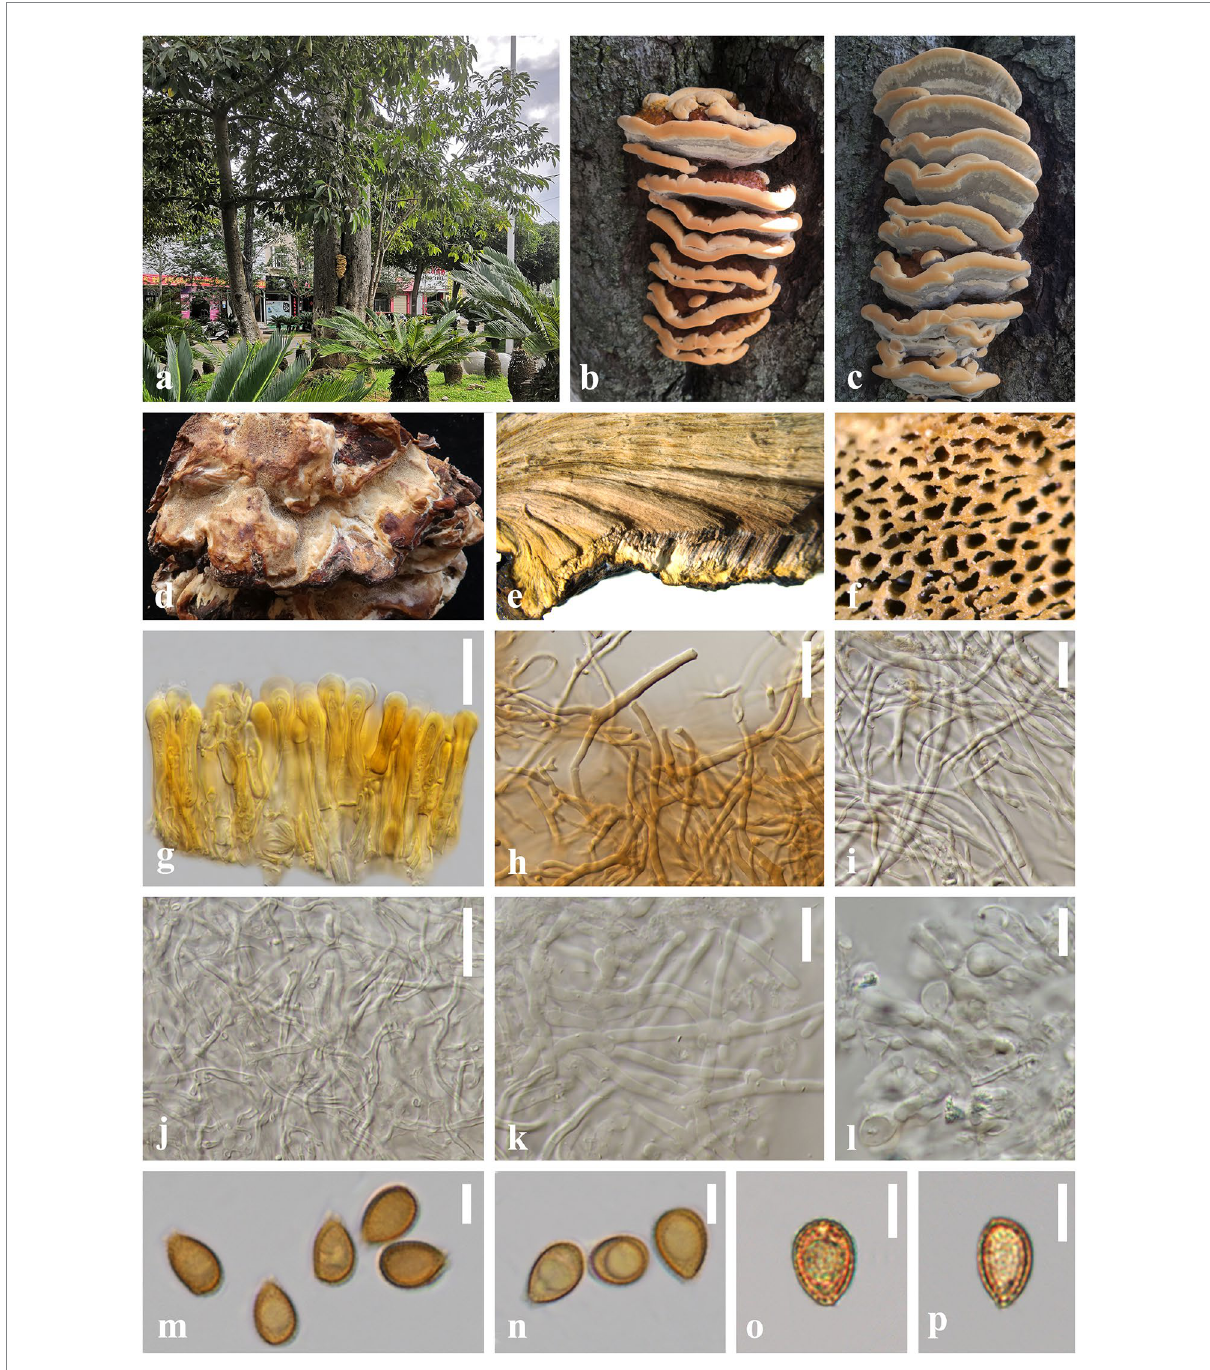
FIGURE 4 Ganoderma artocarpicola (HKAS 123782, holotype) (A–C) Basidiomata in situ on Artocarpus pithecogallus living tree. (D) Lower surface. (E) Transverse section of pileus. (F) Pore surface. (G) Sections of pileipellis. (H,I) Skeletal hyphae from context. (J) Binding hyphae from context. (K) Generative hyphae from tubes. (L) Basidia and basidioles. (M–P) Basidiospores. Scale bars: (G–J) = 20 μ m, (K,L) = 10 μ m, (M–P) = 5 μ m. Photographs were taken by